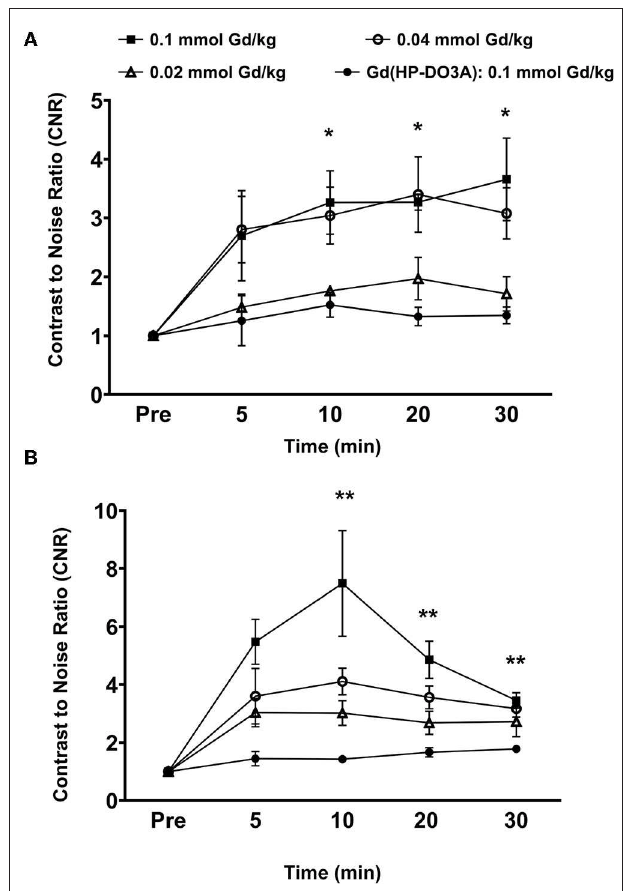
FIGURE 4 | Analysis of fold increase of tumor contrast-to-noise ratio (CNR) from images acquired as indicated in MDA-MB-231 (A) and Hs578T (B) tumors. Data is represented as mean ± s.e.m. n = 5 for MDA-MB-231 and Hs578T tumors. * p < 0.05 for comparison of increased CNR ratio of 0.1 and 0.04 mmol Gd/kg to control Gd(HP-DO3A). No statistical significance was observed between 0.02 mmol Gd/kg MT218 to control. ** p < 0.05 for